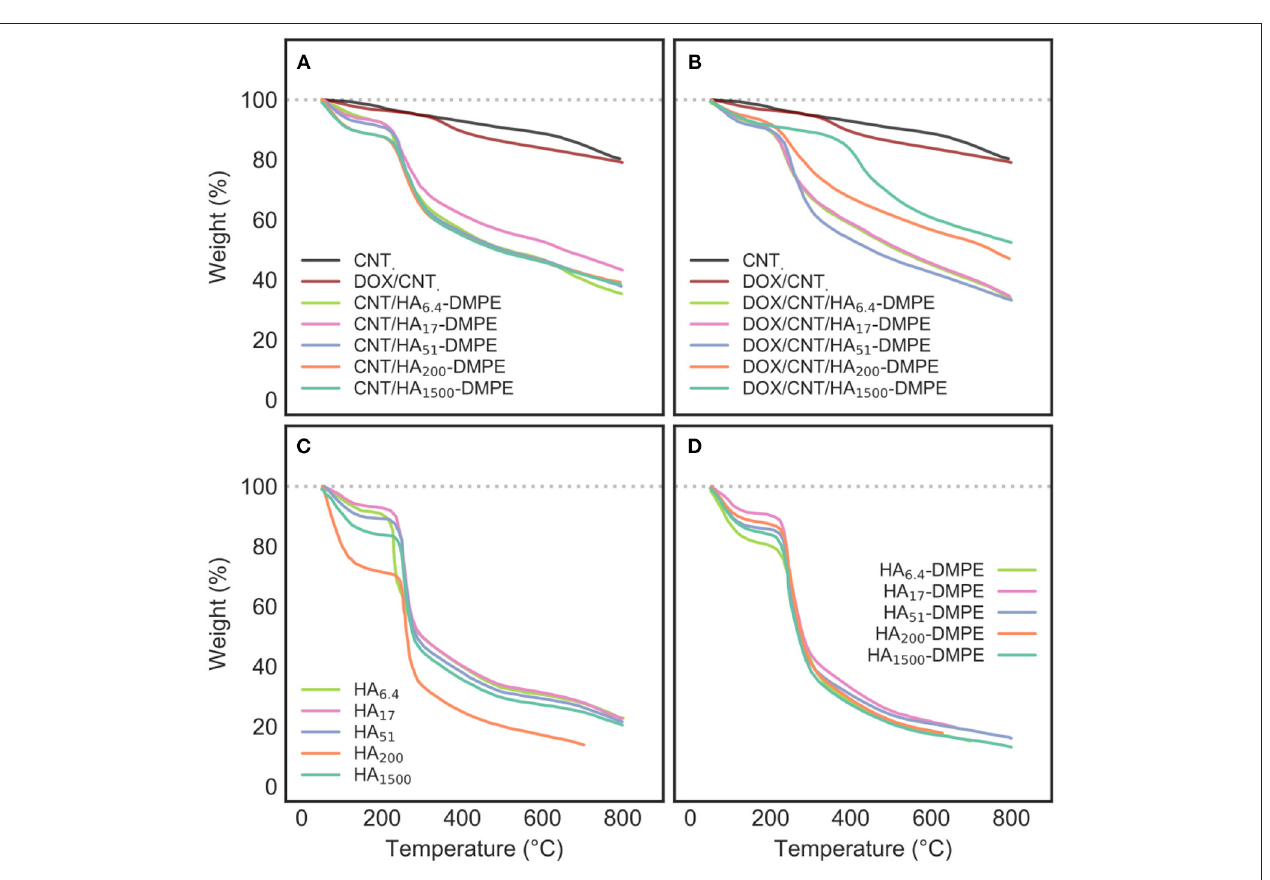
FIGURE 4 | TGA profiles of (A) CNT/HA-DMPE; (B) DOX/CNT/HA-DMPE; (C) HA; and (D) HA-DMPE analyzed at different chain lengths of HA, including 6.4, 17, 51, 200, and 1,500 kDa. The TGA profiles of CNT and DOX/CNT have been included in both (A,B) for